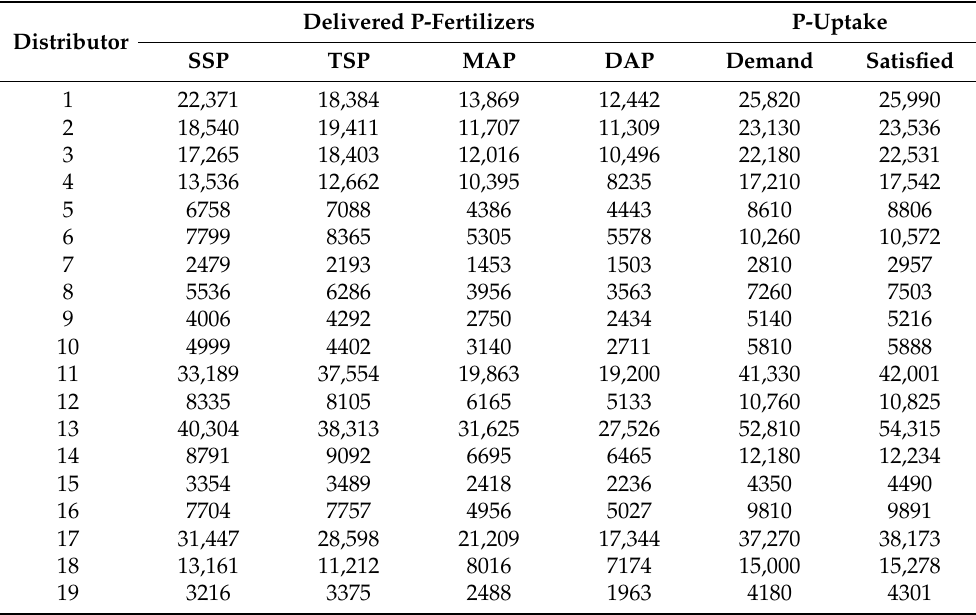
Table 12. Total delivered P-fertilizers (ton) and P-uptake (ton) in each distribution